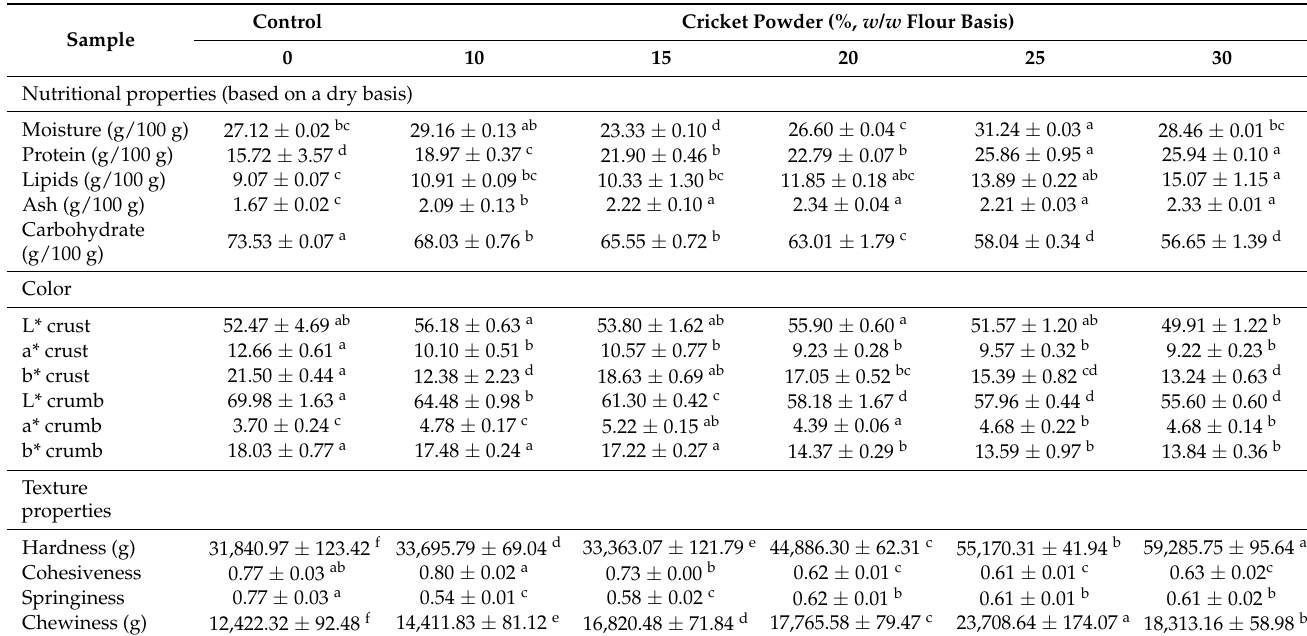
Table 2. Nutritional compositions and physical properties of control and cricket powder-enriched whole wheat